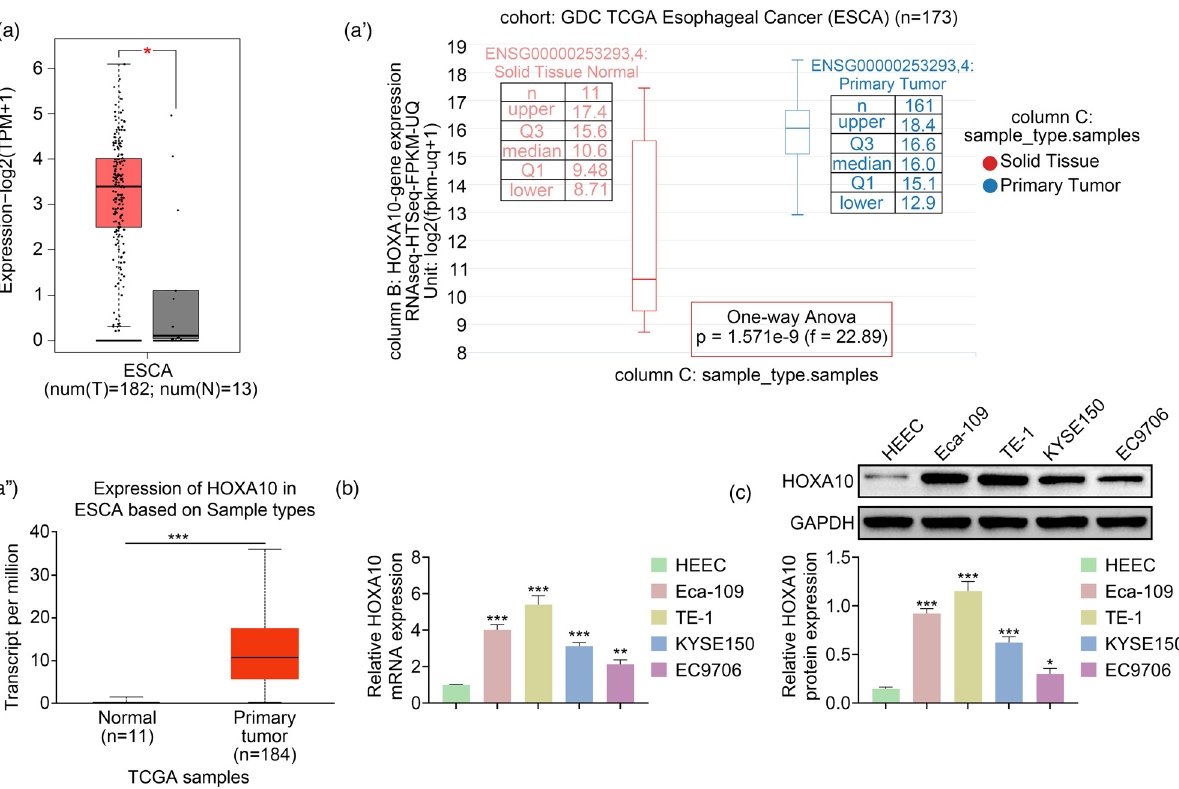
Figure 1: HOXA10 was highly expressed in EC tissues and cells. ( a ) The HOXA10 expression was elevated in primary tumor tissues, which was analyzed by TCGA ( a ) , GEPIA ( a ′ ) , and UCSC Xena ( a ″ ) databases. ( b ) The HOXA10 mRNA level was increased in EC cell lines containing Eca - 109, EC9706, TE - 1, and KYSE150. ( c ) The HOXA10 protein level was promoted in EC cell lines. Each experiment repeated three times. * p < 0 .05, ** p < 0.01, *** p <